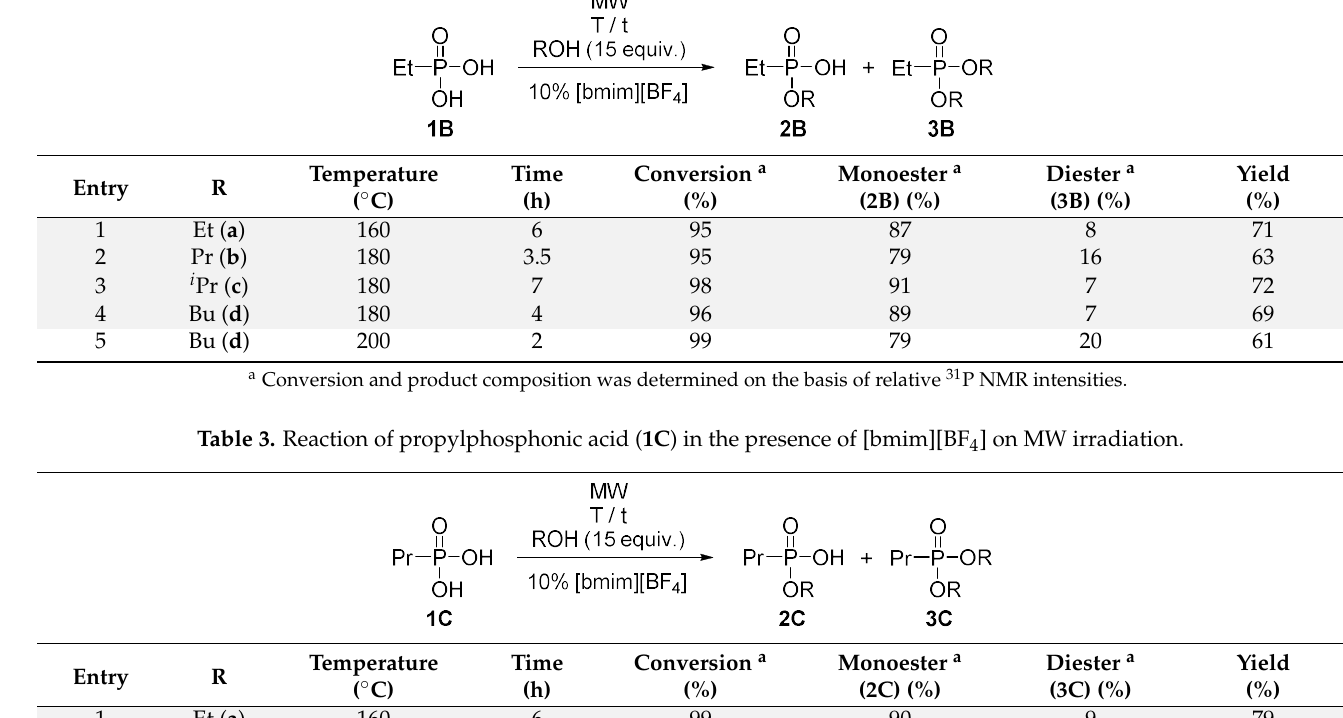
Table 3. Reaction of propylphosphonic acid ( 1C ) in the presence of [bmim][BF 4 ] on MW irradiation.